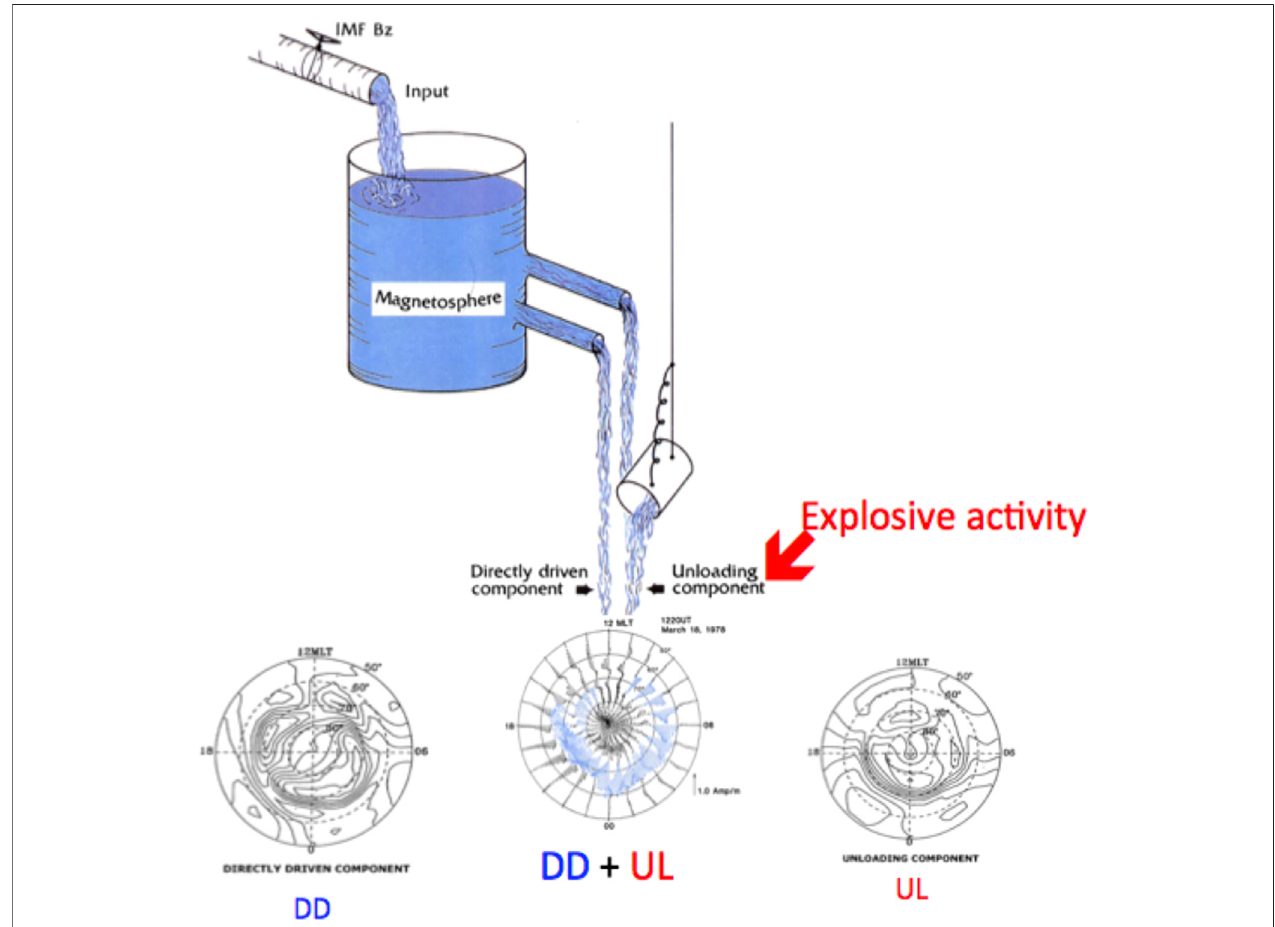
FIGURE 10 | The tank-tippy pitcher model of the role of the magnetosphere. What we can observe by a ground-based magnetometer network is (DD + UL). The fi gure shows also both the DD and UL components.